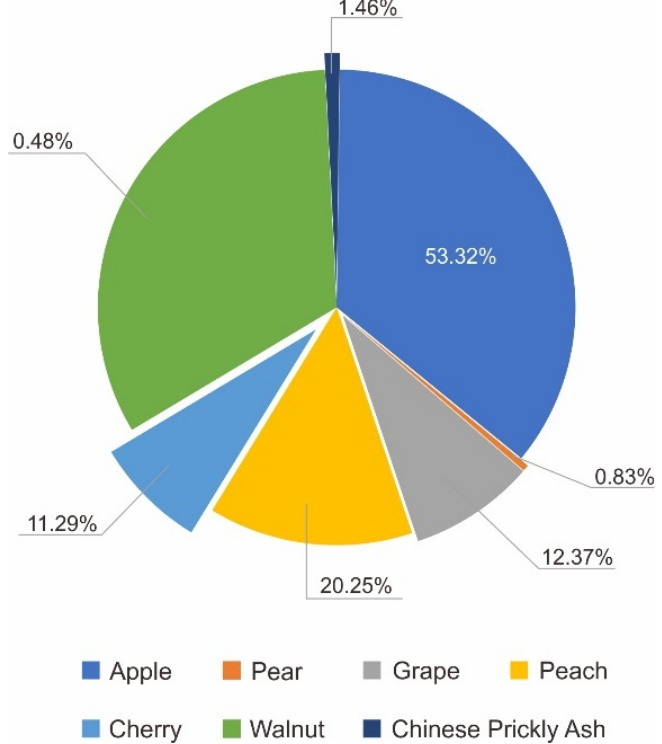
Figure 8. Proportions of product contributing to agriculture carried by garden land.